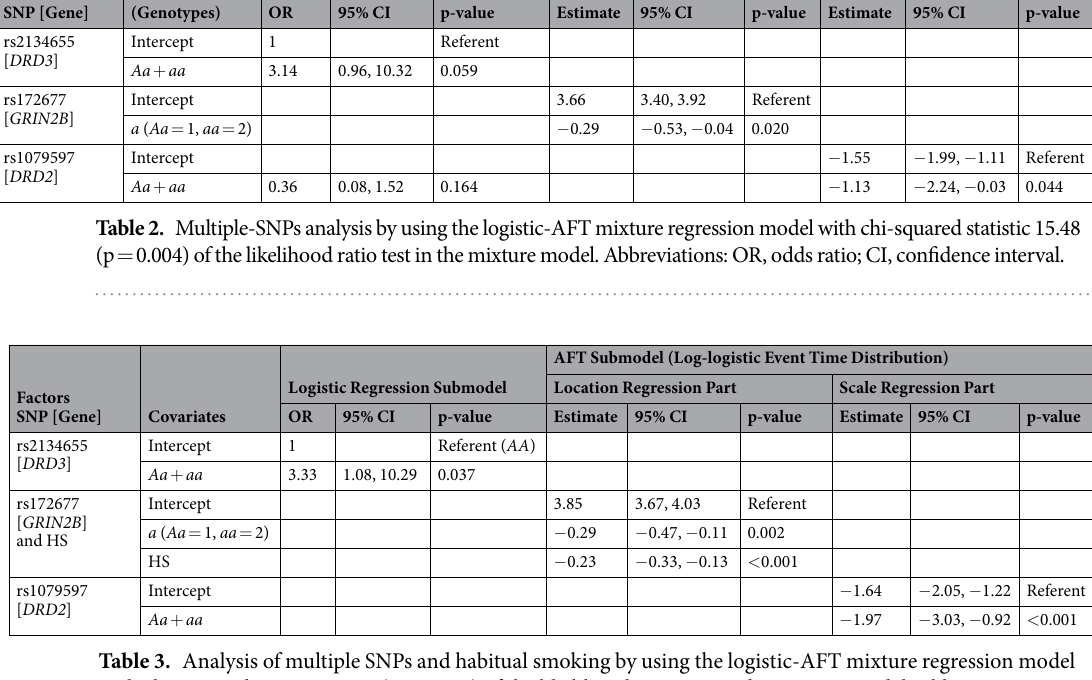
coded in five colors. The dendrogram of the five genes for the Jaccard coefficient matrix G (Fig. 5) on the basis of 23 KEGG path- ways demonstrated that DRD2 (rs1079597) and GRIN2B (rs172677) show the highest similarity with six com- mon pathways belonging to three categories: human diseases (alcoholism and cocaine addiction) in dark yellow,